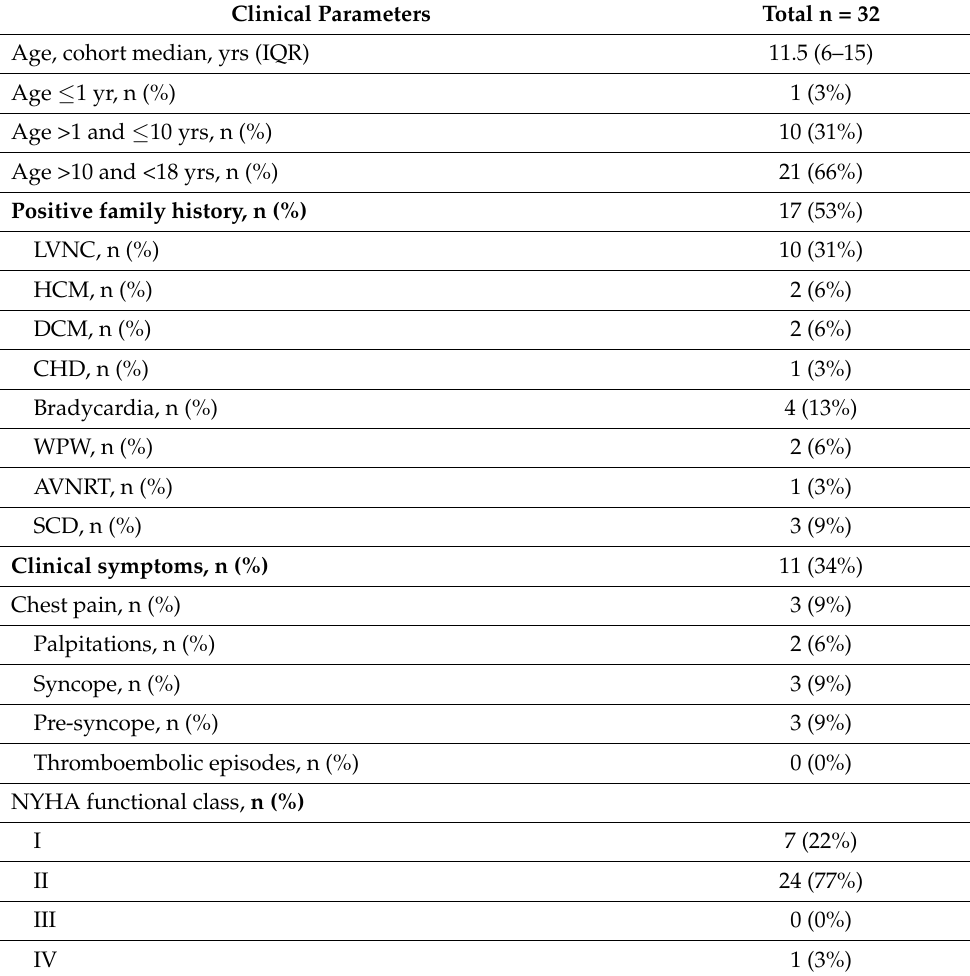
Table 1. Patient characteristics in the whole left ventricular noncompaction cardiomyopathy (LVNC)